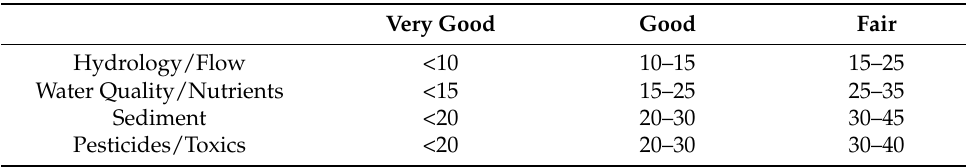
Table 4. PME calibration and validation target values for